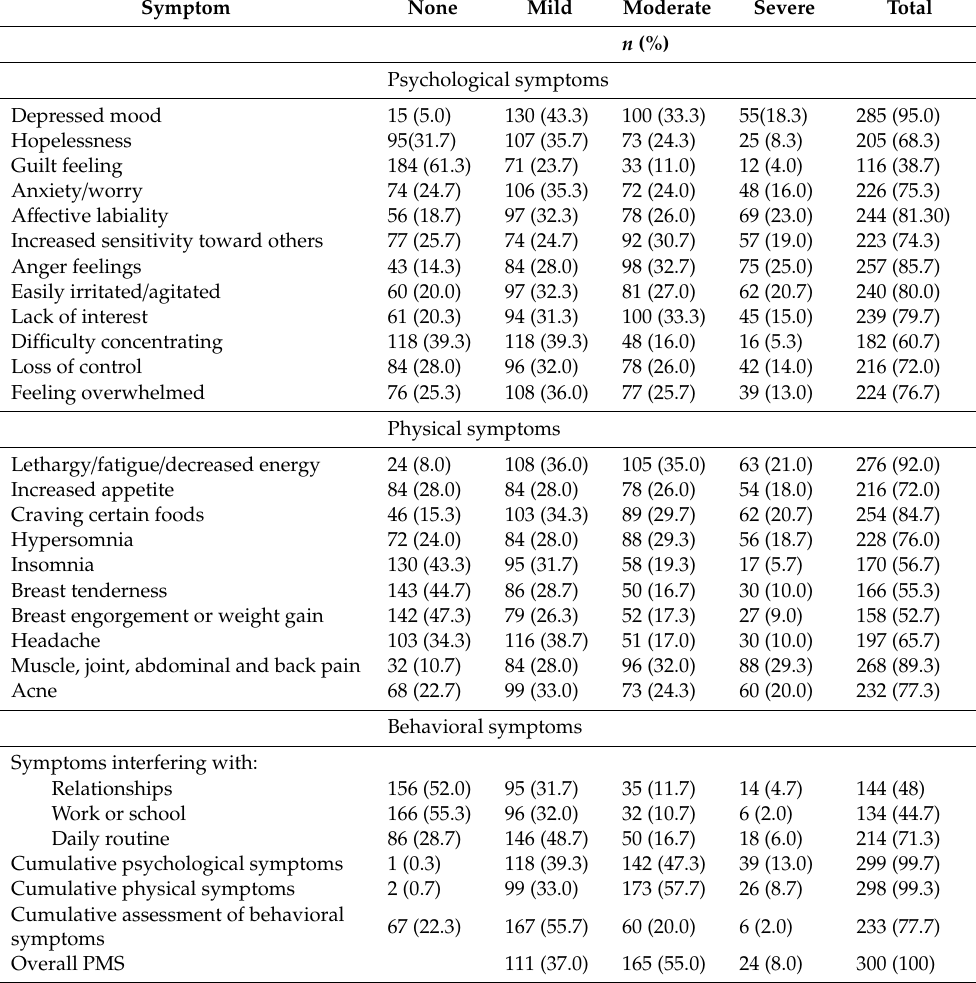
Table 3. Prevalence of premenstrual syndrome symptoms by the level of severity ( n =